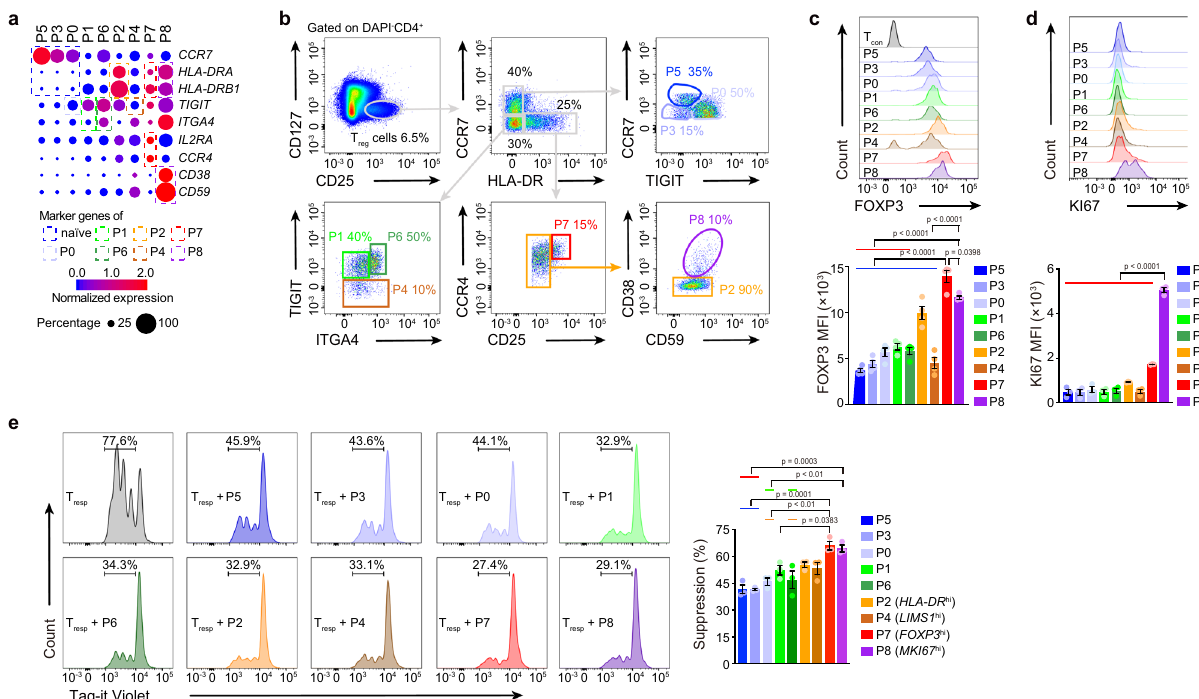
Fig. 2 In vitro assay of T reg cell subsets. a Dot plots showing the expression of indicated genes in each subset. b Gating strategy for HD PB T reg cell subset sorting. c , d Flow cytometry and its quanti fi cation of FOXP3 ( n = 4) and KI67 ( n = 3) in each HD PB T reg cell subset from PBMC. MFI, mean fl uorescence intensity. In c , blue line indicated that P7 was compared with P5, P3, P0, P1, P6, P2 or P4; red line indicated that P8 was compared with P5, P3, P0, P1 or P6. In d , red line indicated that P8 was compared with P5, P3, P0, P1, P6, P2, P4 or P7. e In vitro suppression assay. Tag-it Violet-labeled T resp cells were co- culture with different T reg subsets for 96 h, with CD3/CD28 T cell activator ( n = 3). The T reg : T resp ratio was 1: 2. The Tag-it Violet dilution of T resp cells was assessed by fl ow cytometry. Blue line indicated that P7 was compared with P5 or P3; orange line indicated that P7 was compared with P0 or P6; red line indicated that P8 was compared with P5 or P3; green line indicated that P8 was compared with P0 or P6. In c - e , experiment repeated at least three times; p values were determined by One-way ANOVA, part of the statistical signi fi cance was shown in the pictures and the whole ANOVA results were given in Supplementary Data 11; data are presented as mean values ± SEM. Source data are provided as a Source Data fi